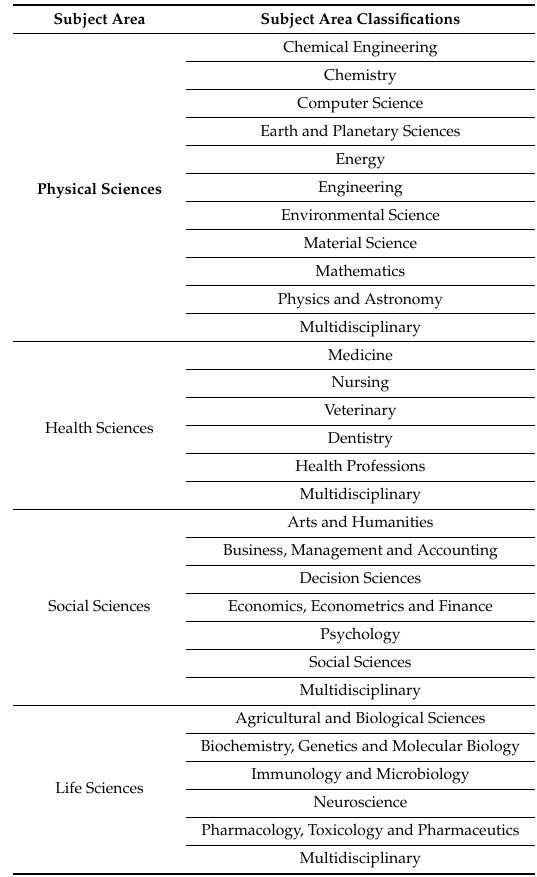
Table 1. ASJC (All Science Journal Classification)